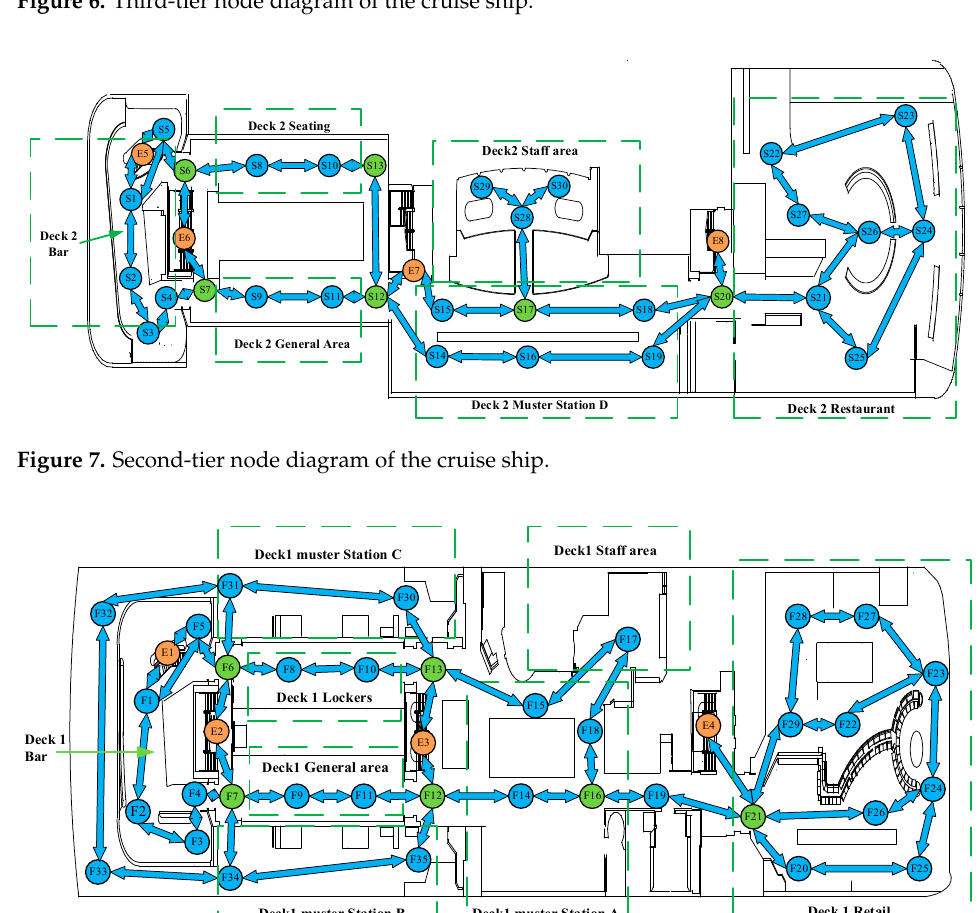
Figure 8. First-tier node diagram of the cruise ship.